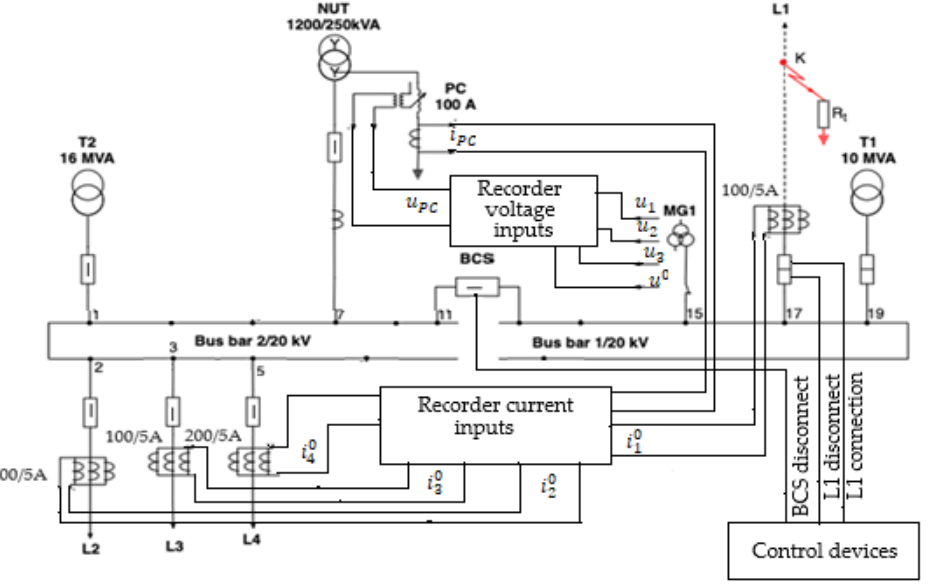
Figure 5. Wiring diagram of the data acquisition equipment and recording of the measured parameters. The parameters were recorded with a digital recorder (CDR-10 in Figure